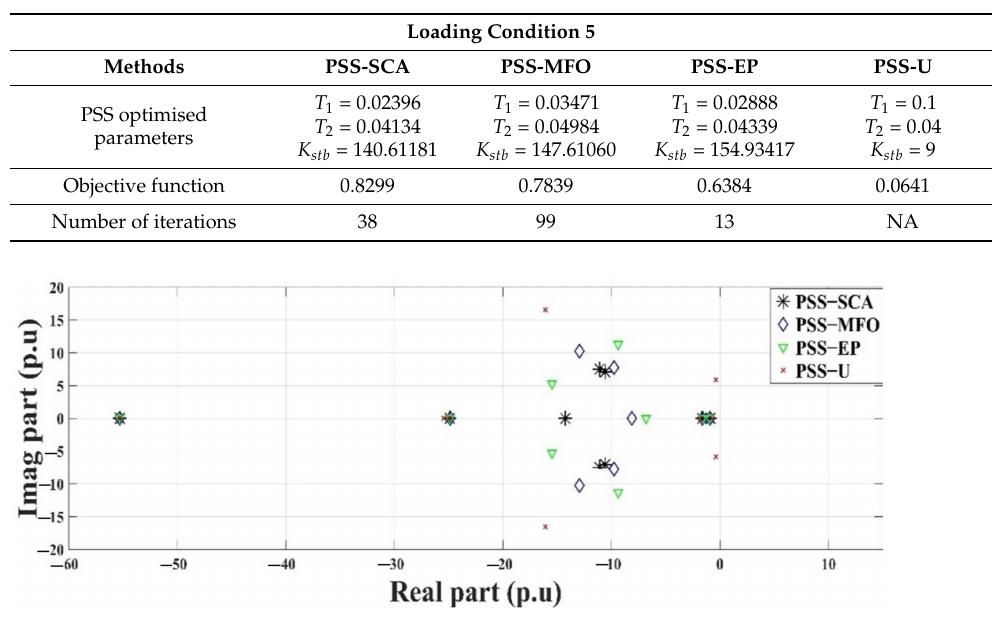
Figure 14. Eigenvalue’s location on the complex s-plane for loading condition 5 of the SMIB with